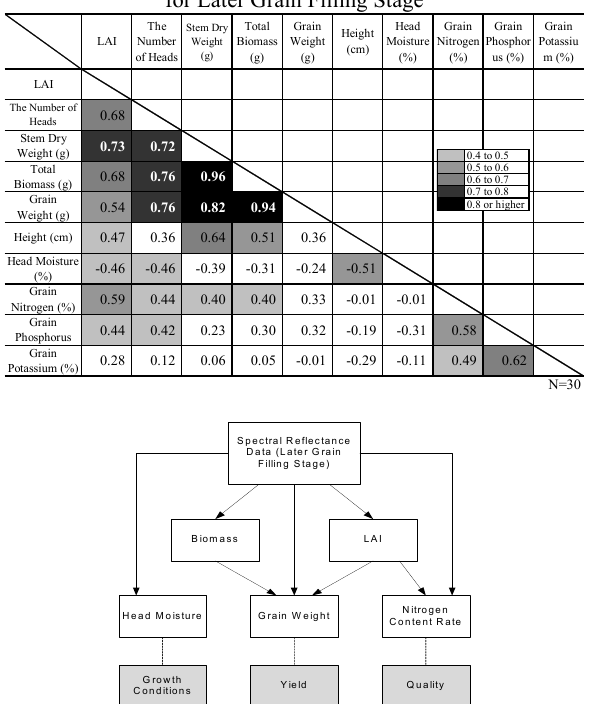
Figure 4: Estimation Items for Later Grain Filling Stage